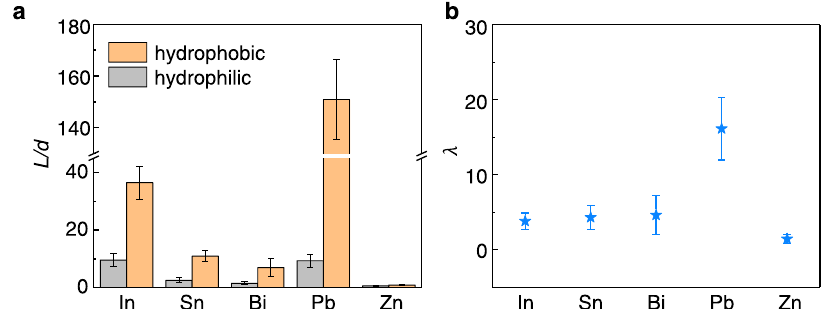
Fig. 4 | Generality of the enhanced molding ef fi ciency in TMNM of crystalline metals by using superhydrophobic nanomolds. a Examples of super- hydrophobic surface-assisted nanomolding of metals with different crystalline structures at 0.6 T m , which is enabled by TMNM with silanization treated AAO nanomolds, i.e. In (Monoclinic), Sn (Tetragonal), Bi (Triclinic), Pb (Cubic), and Zn